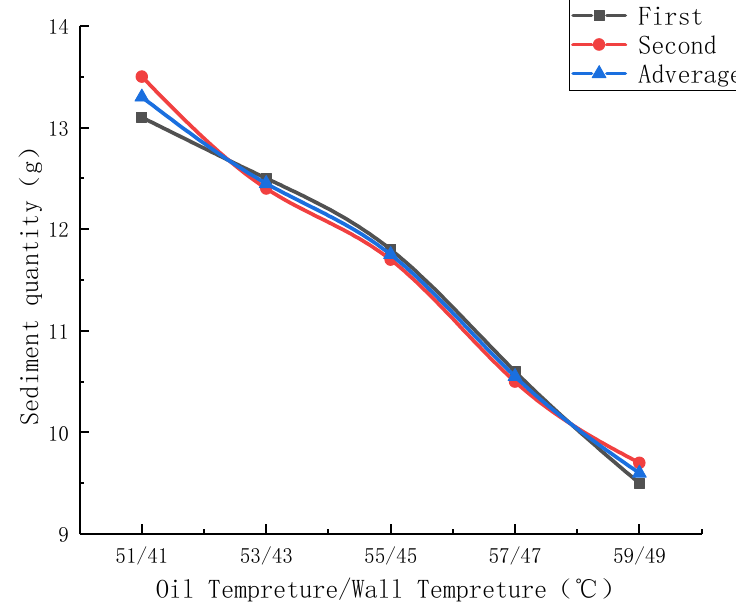
Figure 3. Sediment quality curves at the ranges of different temperatures.